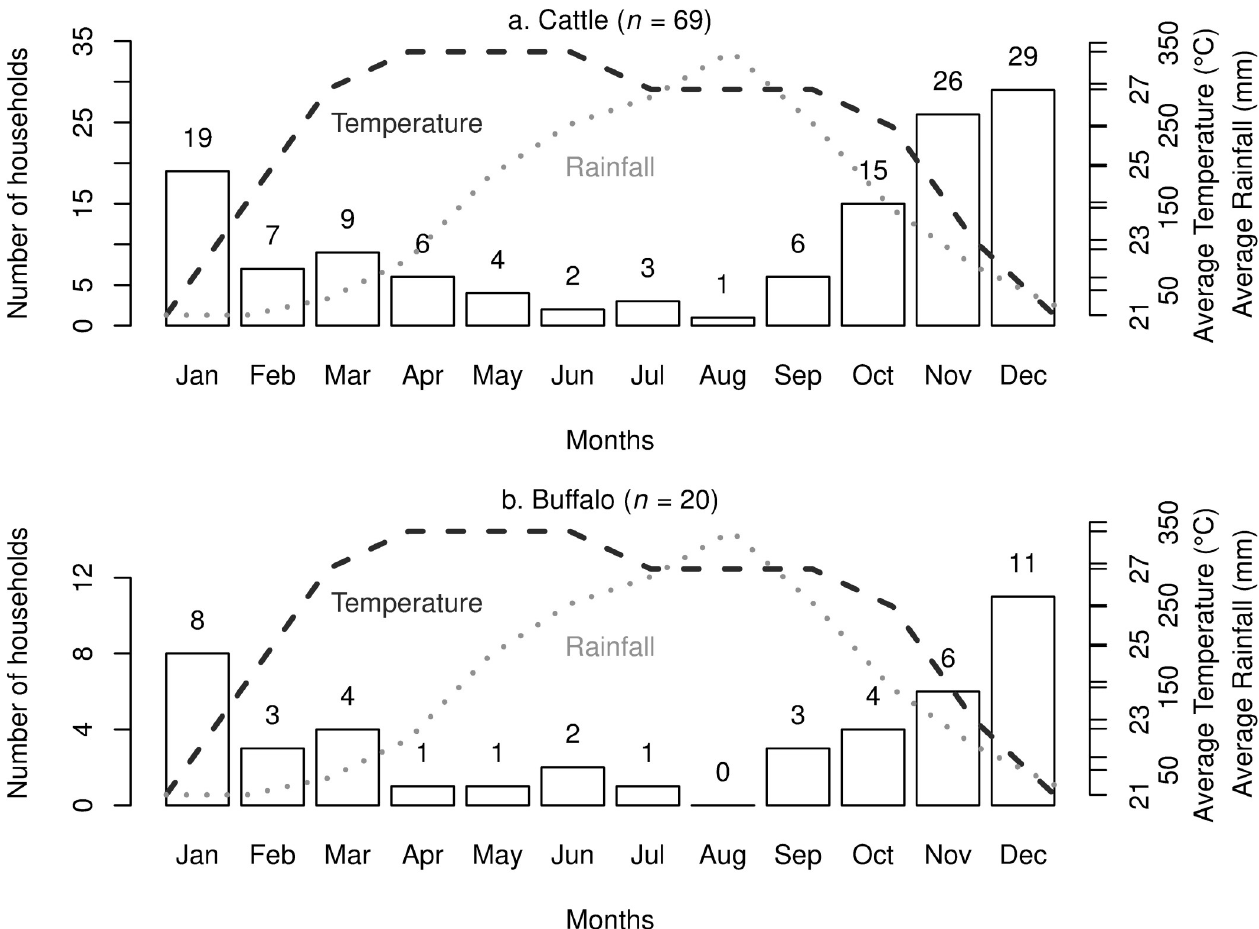
Fig 2. Histograms of the main calving months reported by smallholder farms in 2018, Lao PDR. (a) cattle calves (b) buffalo calves. Temperature data are from the Meteorological Organization Standard Normals 1961–1990 [44] and rainfall data from the Climate Change Knowledge Portal 1901–2015 [45].